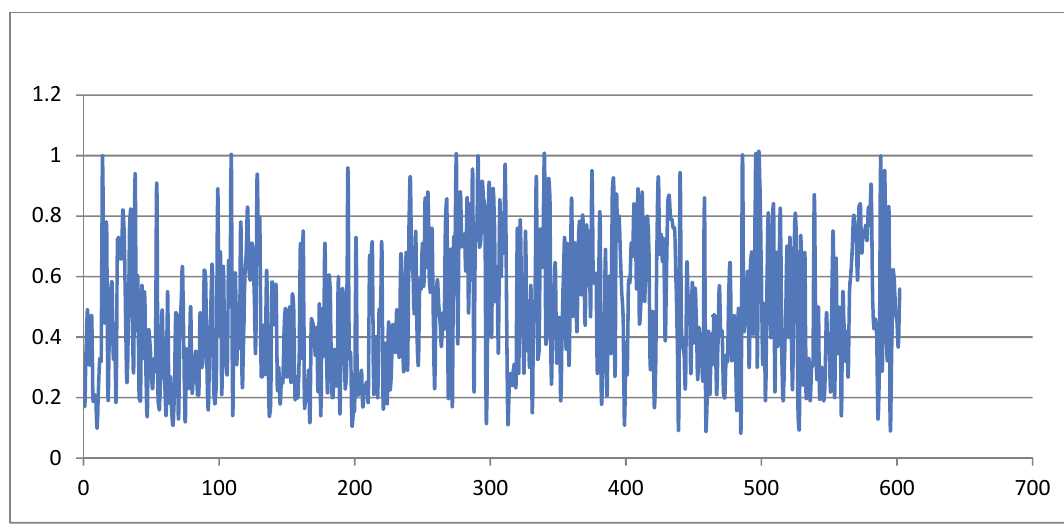
Fig. 3. The results of measuring the relative efficiency of different